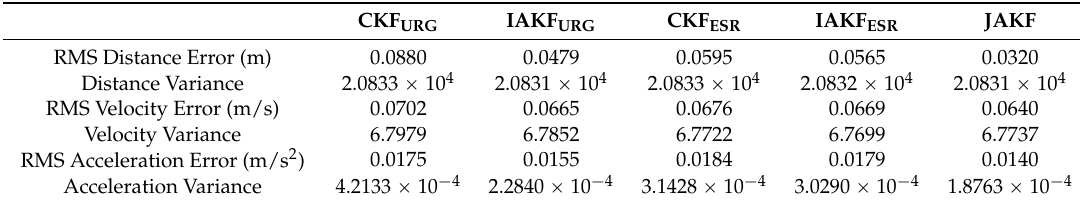
Table 3. Error comparisons of CKF, IAKF, and JAKF.